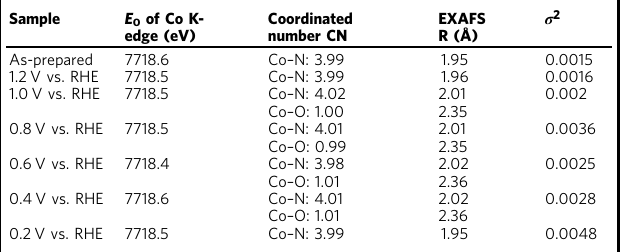
Table 2 EXAFS fi tting parameters for sample under catalytic state with O-based adsorbates: amount of O varied from 0 to 2.